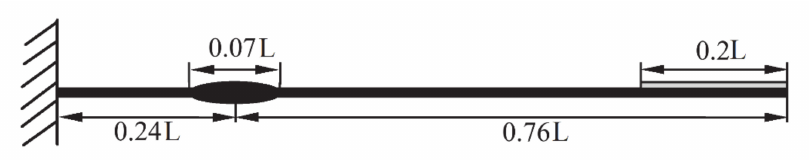
Figure 6. Visualization of finite element (FE) model developed in the Comsol Multiphysics software.